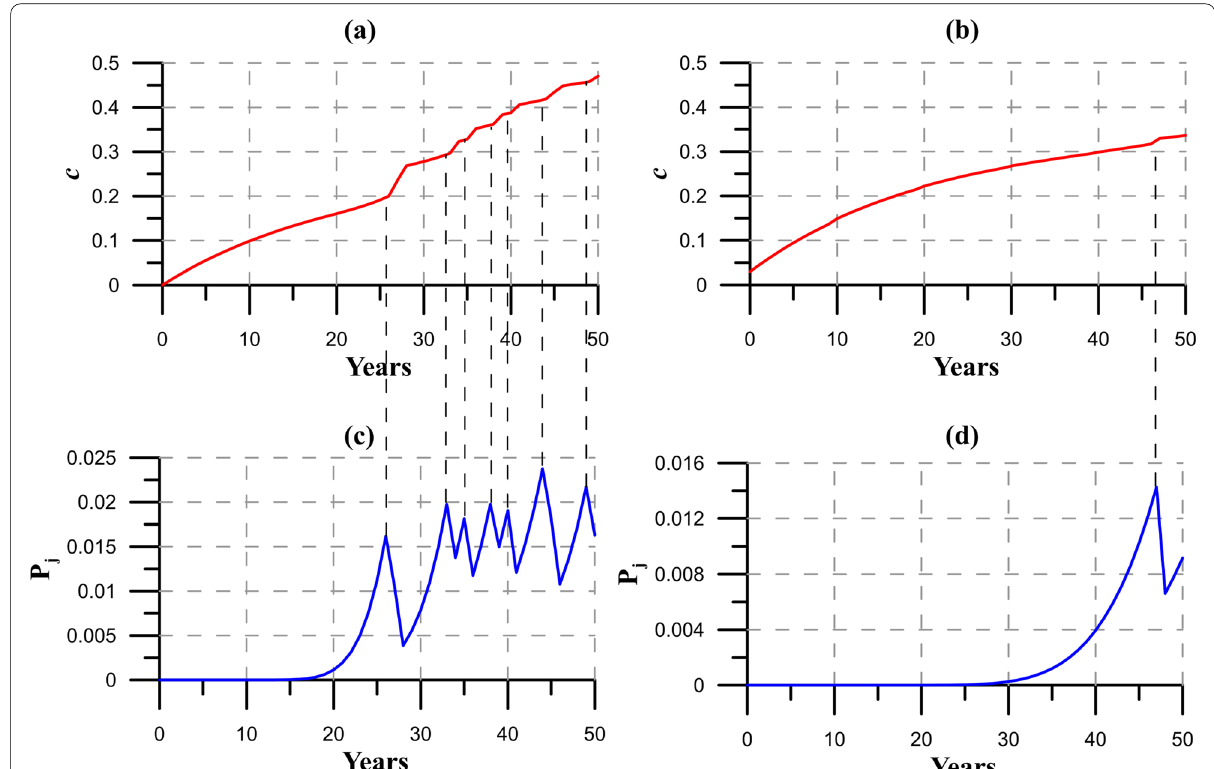
Fig. 9 Expected normalized costs over the lifetime of the bridge ( a - b ) and the respective trends of the probabilities ( c - d